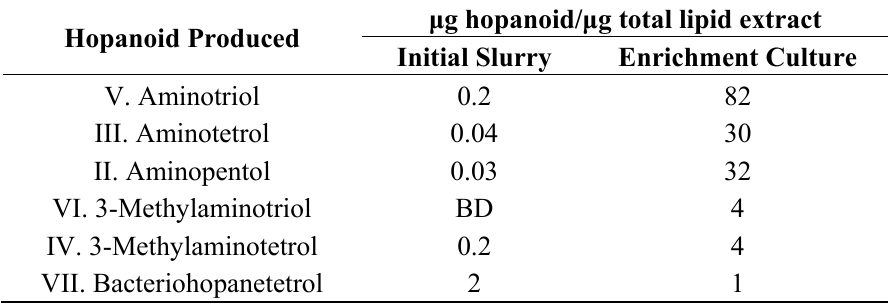
Table 2. Hopanoid production measured in Herman Pit